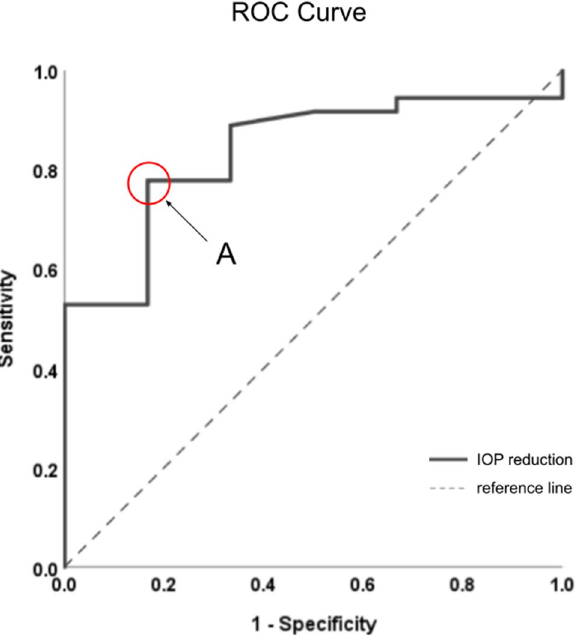
Figure 4. Receiver operating characteristics (ROC) curve for post-trabeculopuncture IOP reduction in detecting ab interno trabeculectomy responders. Point A corresponds to a 5% IOP drop (resembling a 10% IOP reduction) after trabeculopuncture representing a sensitivity of 76.4% and specificity of